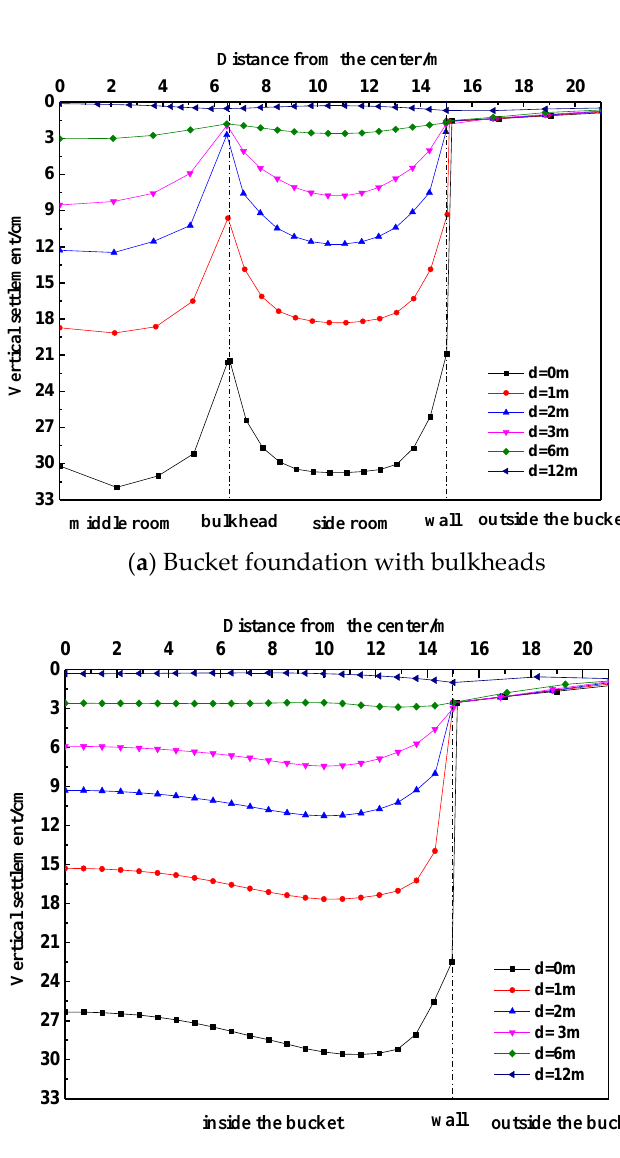
Figure 6. Vertical settlements with distance from the centre at different depths.